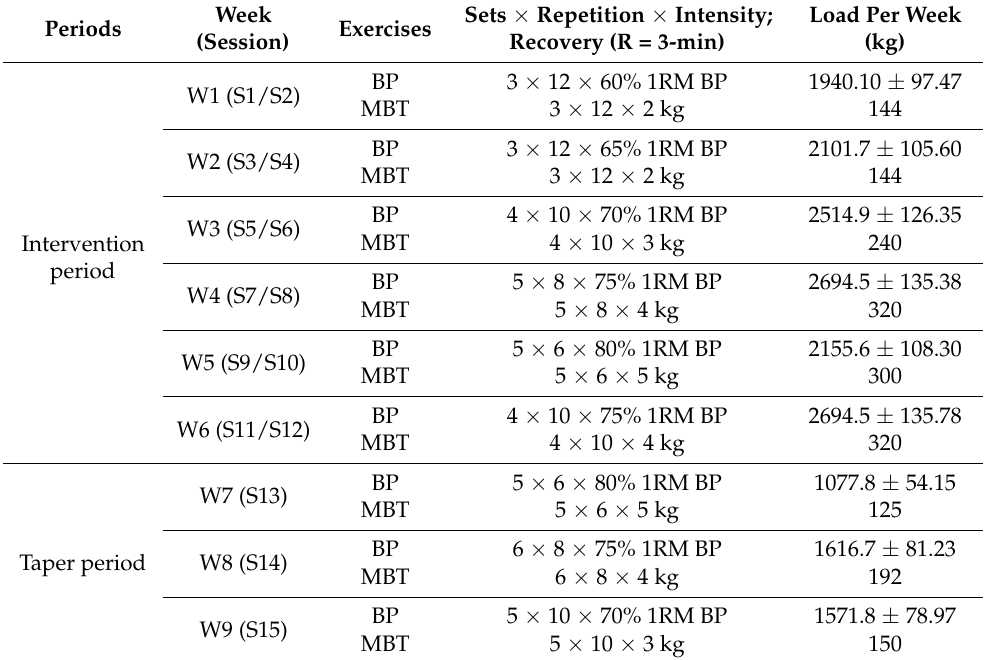
Table 2. Upper body dry land training program during the intervention and taper periods.